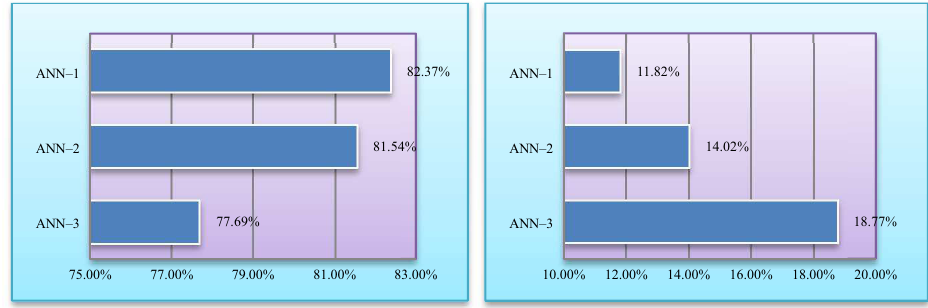
Fig. 5. Average results of overall accuracy Fig. 6. Average results of type – I error